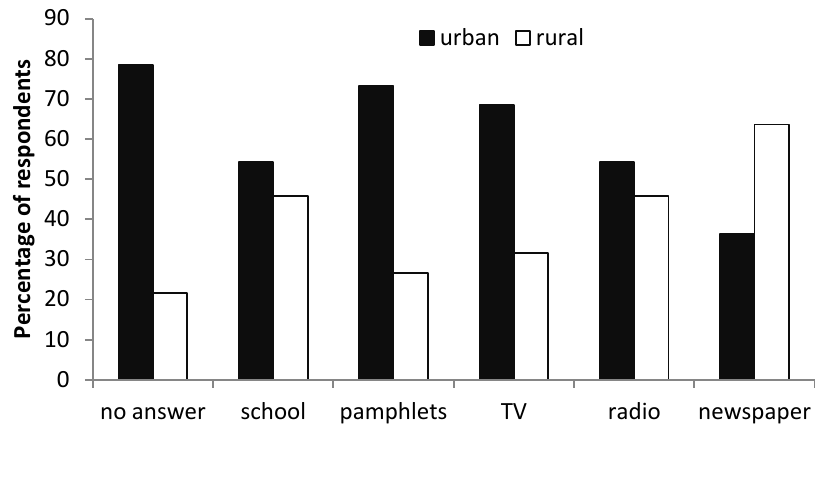
Figure 2. The different sources of information on waterborne